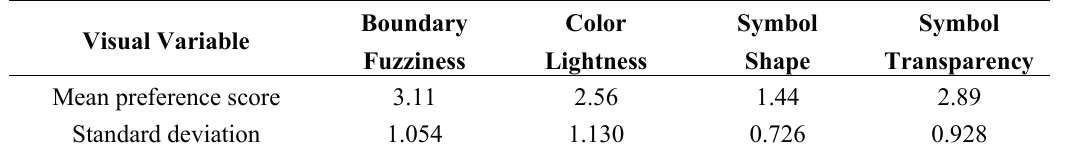
Table A3. The mean and standard deviation of preference scores of the four visual variables in representing uncertainty by participants in neither group.